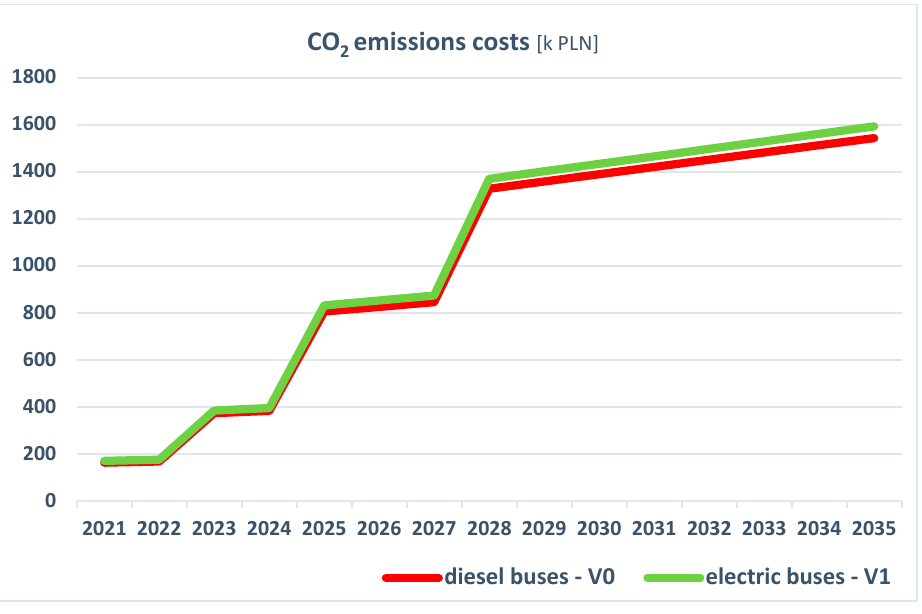
Figure 7. Projected amounts of SO 2 emissions costs of the public bus fleet in Szczecin in the 2021–2035 period for variants V0 and V1.